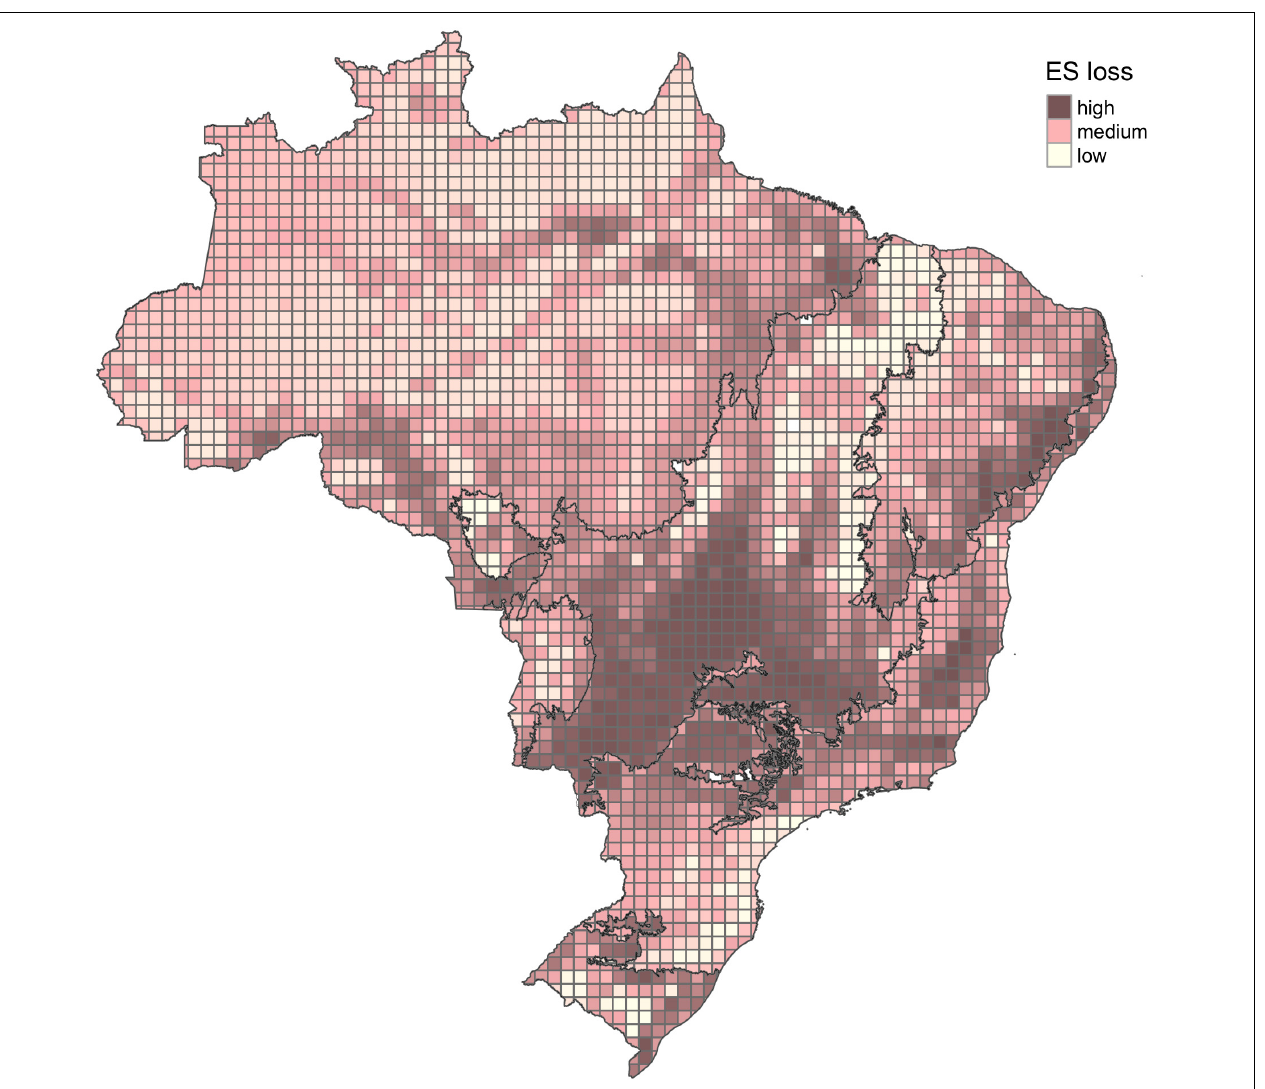
Frontiers in Ecology and Evolution |